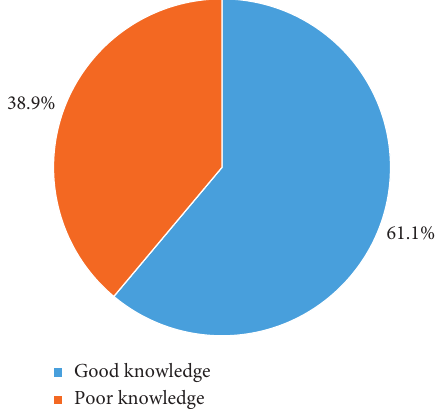
Figure 1: Overall nurses’ knowledge on paediatric pain management.